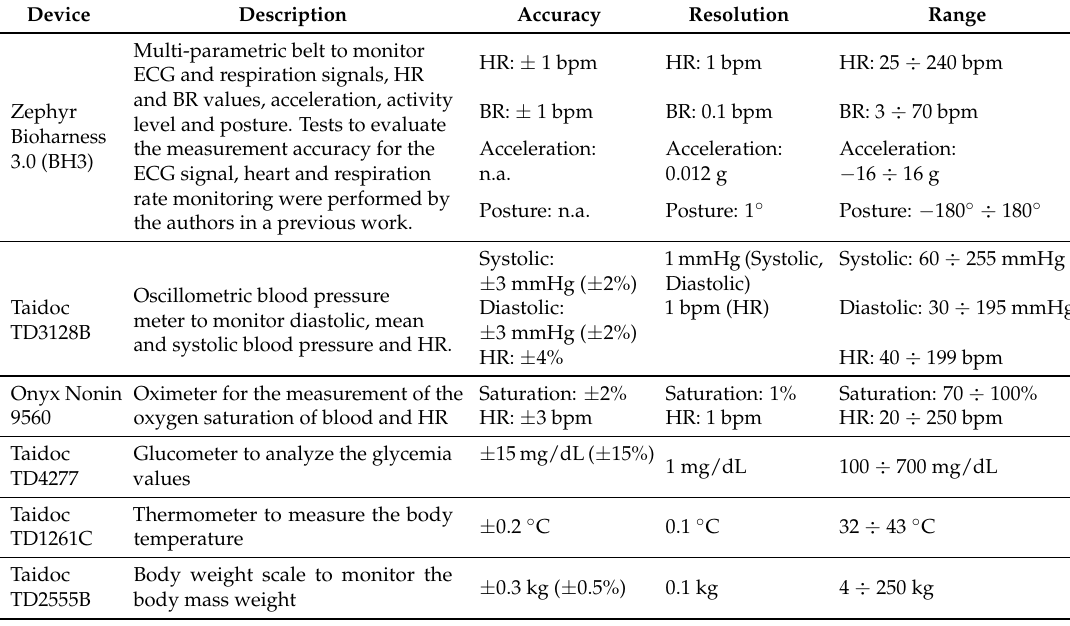
Table 1. Description of the devices part of the developed Physio Kit . Device Description Accuracy Resolution Range